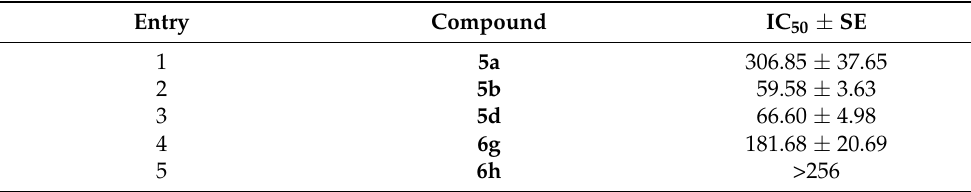
Table 3. Cytotoxicity index (IC 50 ± SE, n = 30) for the obtained compounds on human embryo kidney cells (HEK-293) (µM).